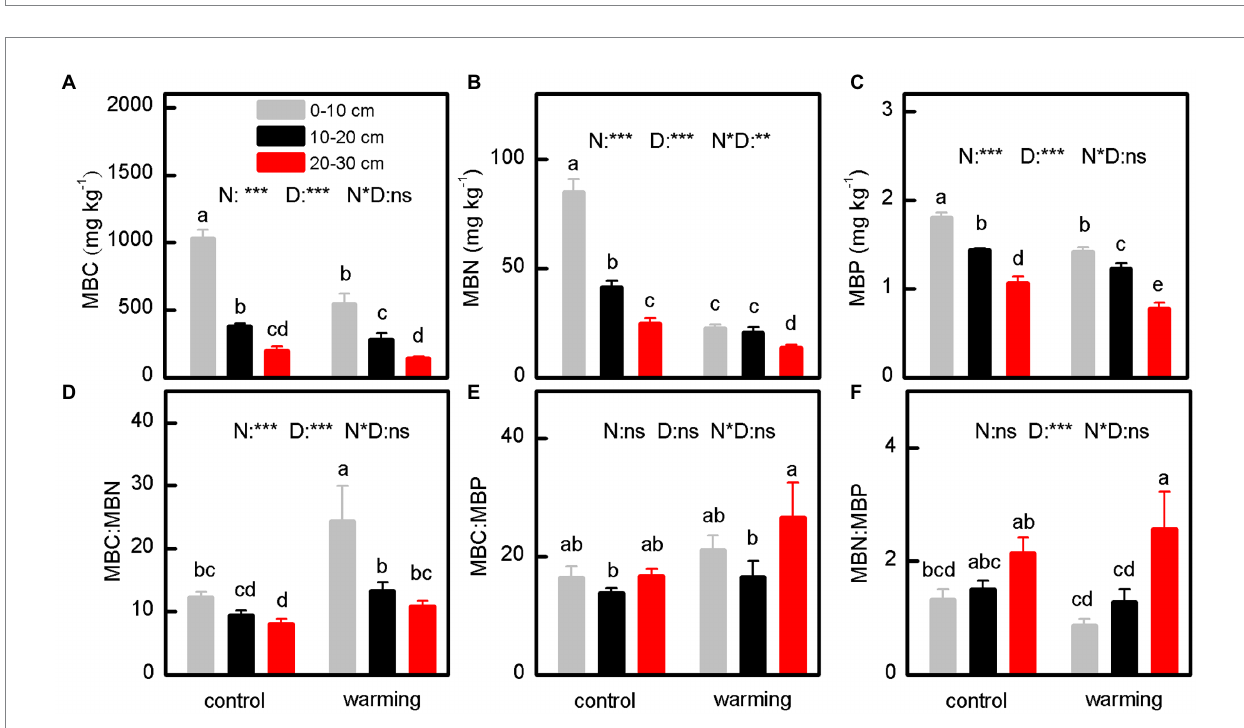
FIGURE 4 The microbial biomass carbon (A) , microbial biomass nitrogen (B) , microbial biomass phosphorus (C) , and their stoichiometric ratios (D–F) of soil under control and warming. p -value of the ANOVA of treatments (control and warming, N), soil depths (0–10, 10–20 and 20–30 cm, D) and interactive of treatments and soil depths (N*D) is indicated: * p ≤ 0.05; ** p ≤ 0.01; *** p ≤ 0.001; ns, not